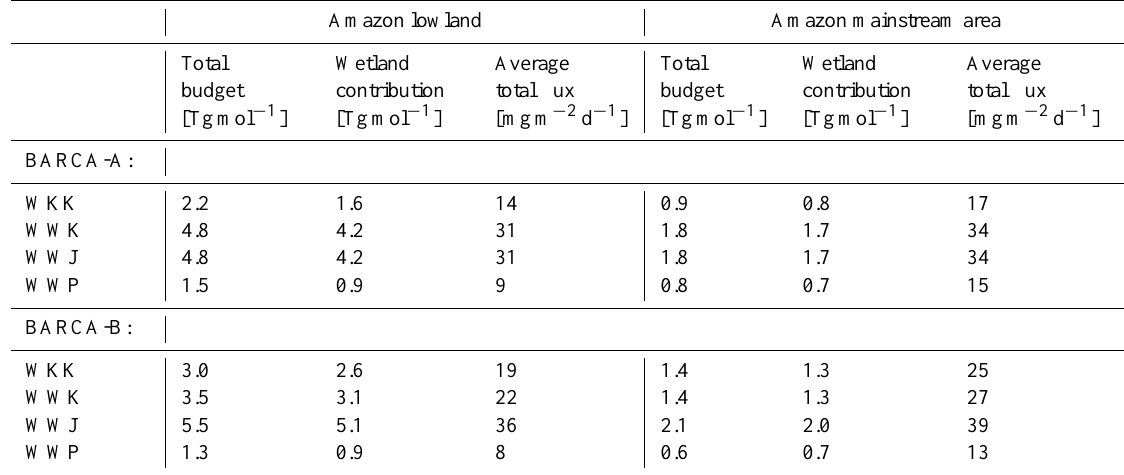
Table 5. Calculation of the total CH 4 budget numbers [Tgmol − 1 ] and the wetland contributions of the four different WRF-GHG simulations for the Amazon lowland and Amazon mainstream region (see